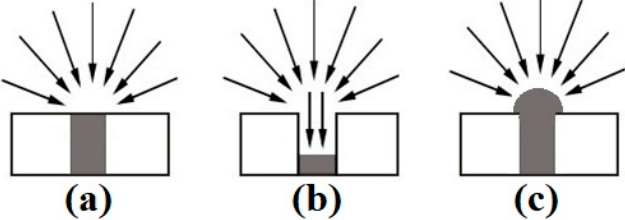
Figure 1. Illustration of diffusion profiles to ( a ) an inlaid disc, ( b ) a recessed disc, and ( c ) a hemispherical microelectrode [10].